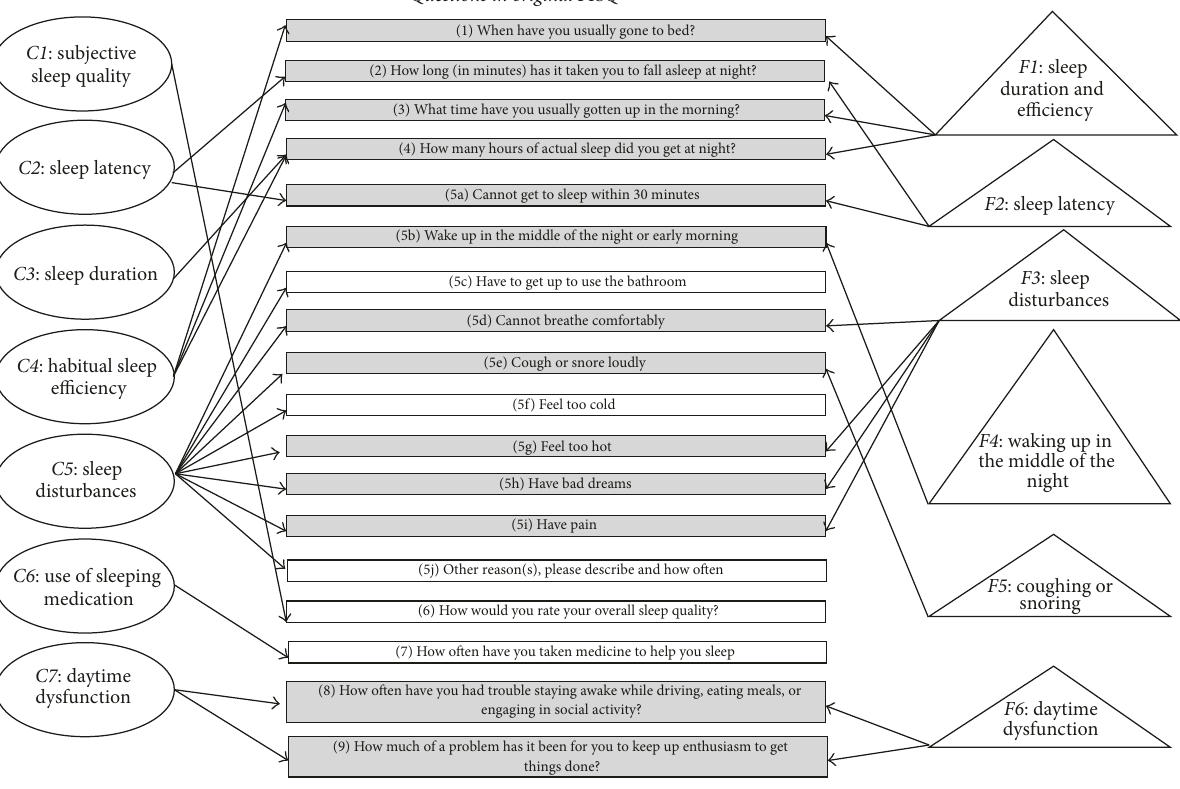
Figure 1: Graphical representation of seven clinically determined components (ovals) of original PSQI and their corresponding questions (rectangles) as well as the factor analysis-based six factors